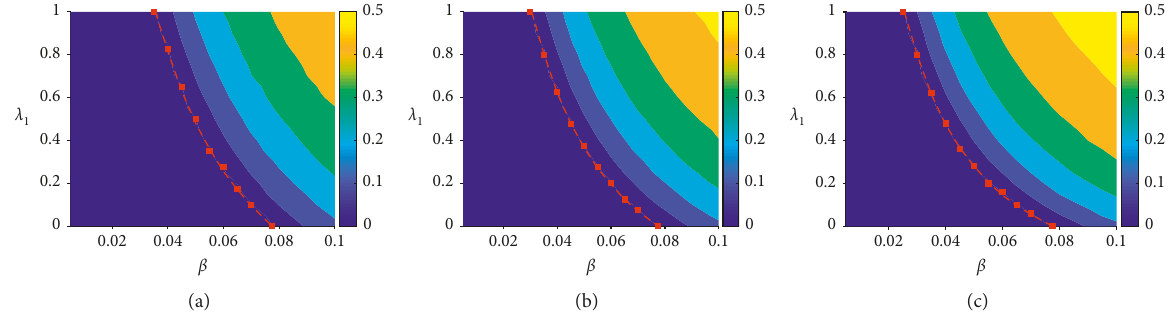
Figure 7: The final fraction of infectious nodes as a function of the infection rate β and the group interaction probabilities λ subgraph, the curve with markers represents the dependence of the predicted critical value λ c rate β . λ c suggested by Monte Carlo simulations is obtained in the same way as deriving the critical value of β in Figure 5. (a) λ 2 � 0.1 λ 1 ; 1 (b) λ 2 � 0.5 λ 1 ; (c) λ 2 � λ 1